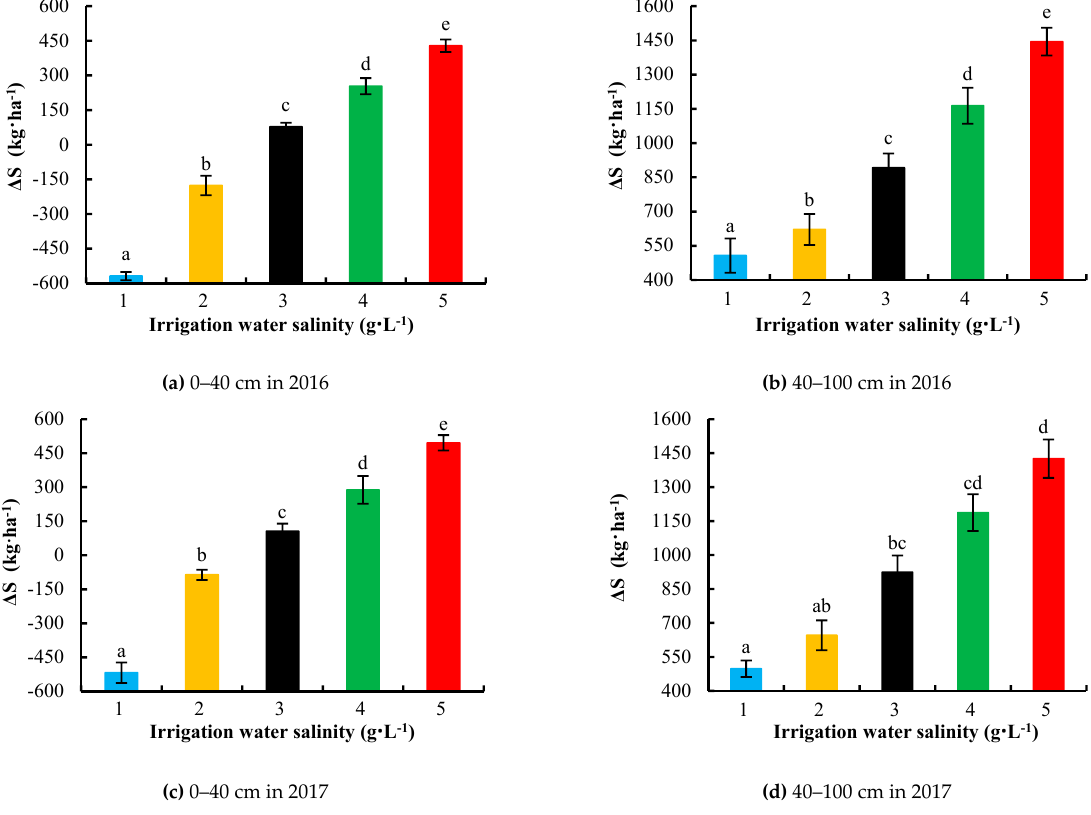
Figure 9. Variation of soil salinity during the growth period of maize for different treatments inside the film. Note: The same letter above the error bars represents no significantly different at p ≤ 0.05.